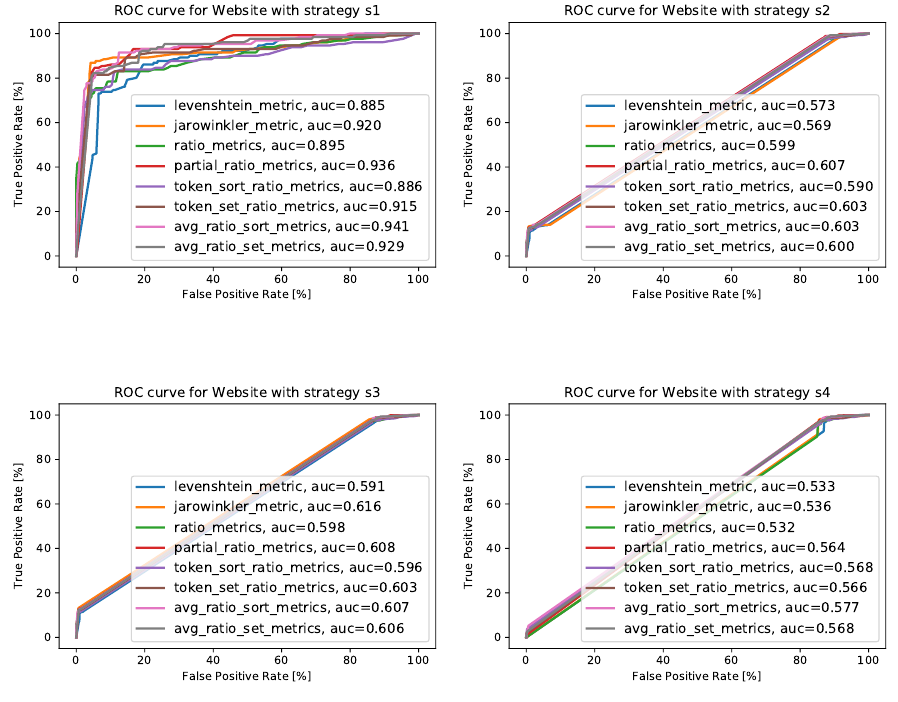
ROC curve for Website with strategy s2